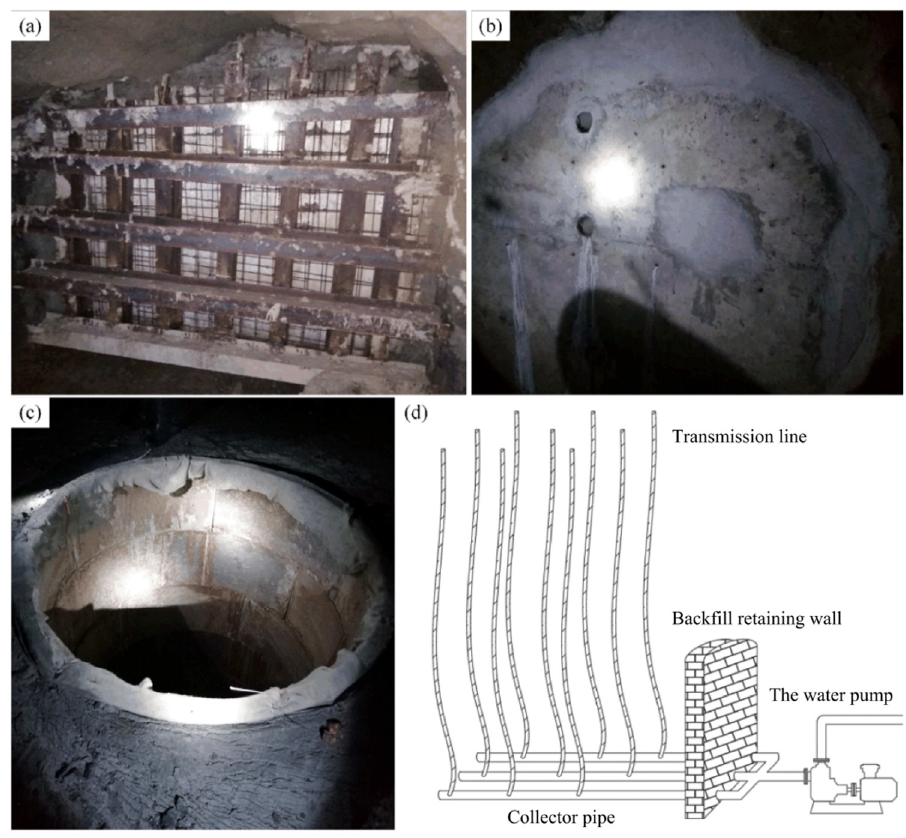
Figure 7. Commonly used filling slurry filtration device: ( a ) Geotextile drainage; ( b ) Drainage hole drainage; ( c ) Drainage of drainage wells; ( d ) New pumping, drainage, and filtration units.